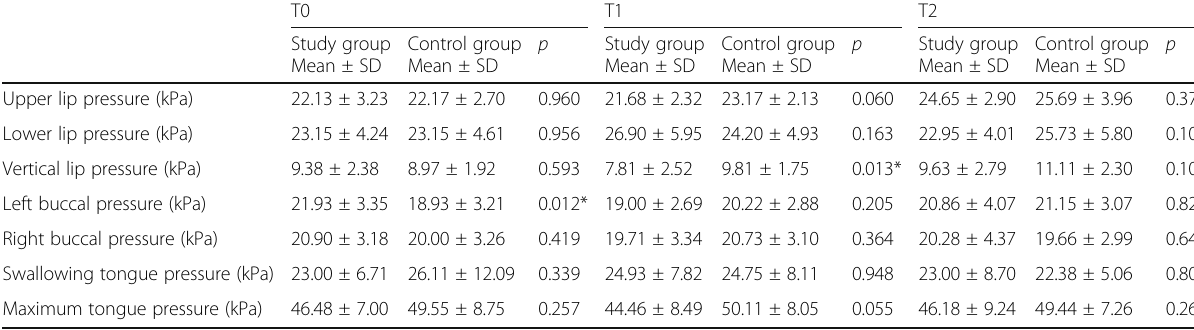
Table 4 Comparison of pressure measurements according to the treatment stages between the study and control